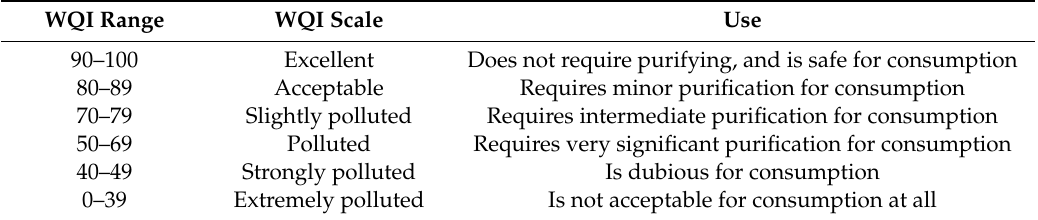
Table 3. Water quality classification according to the WQI ranges